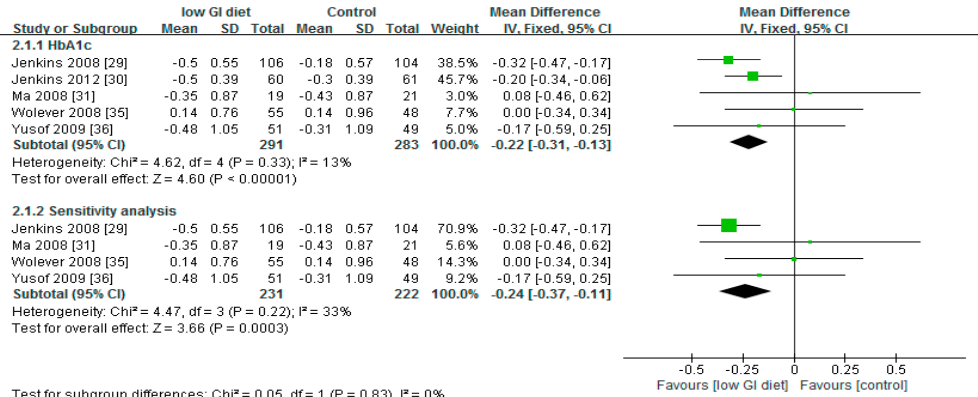
Figure 4. A forest plot showing the effect of low-GI diet on glycated haemoglobin (%).